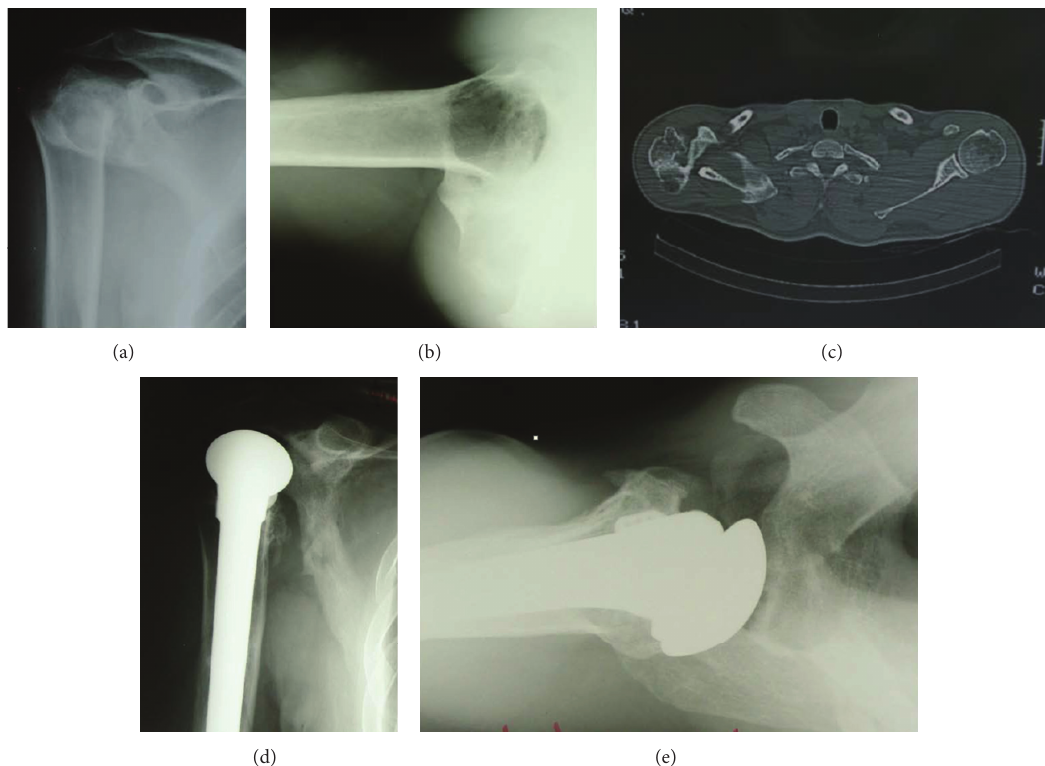
F 3: Patient no. 30: neglected posterior locked dislocation treated conservatively elsewhere. Very good result 5.5 years postoperatively with a Constant score of 76